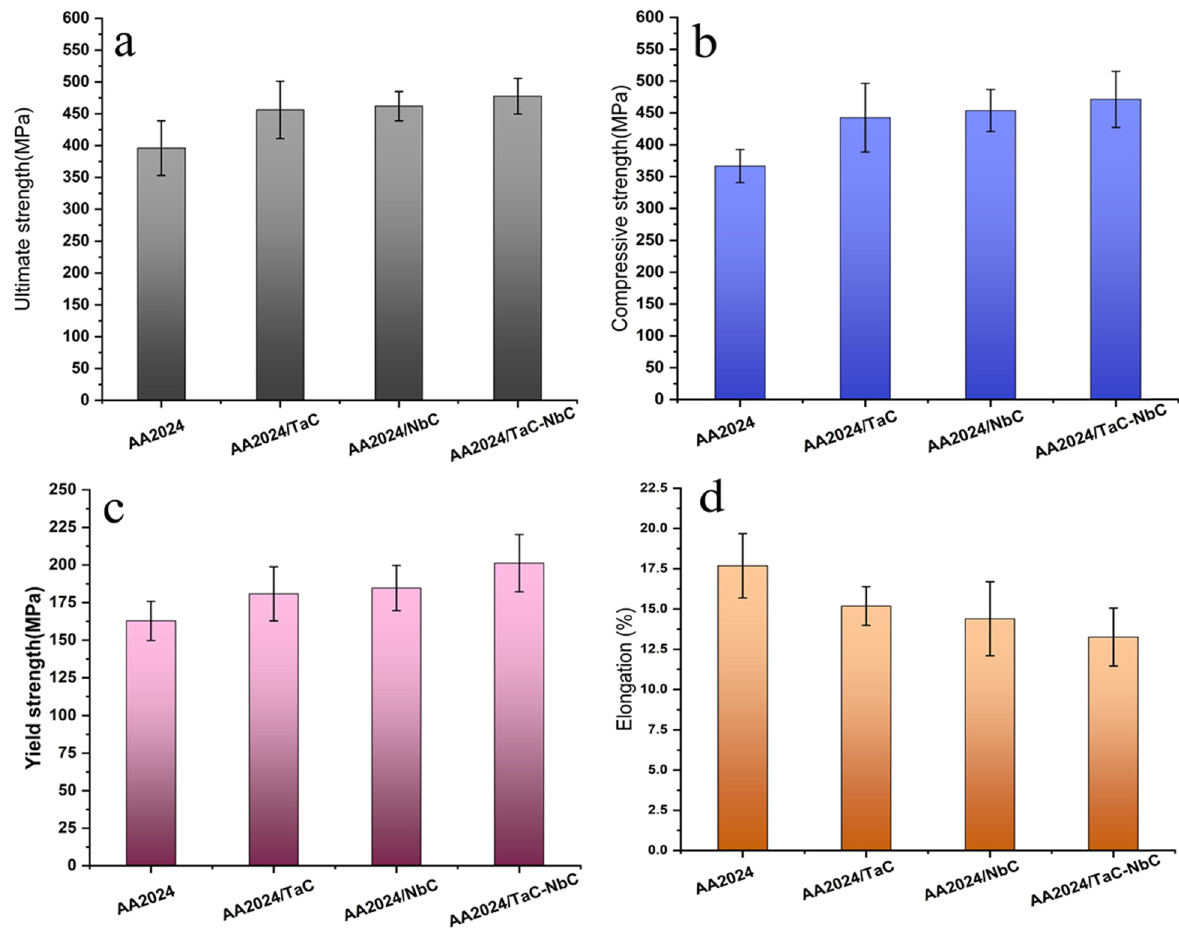
Figure 13.: ( a ) UCS, ( b ) CS, ( c ) YS, and ( d ) E of AA2024 and its composites.